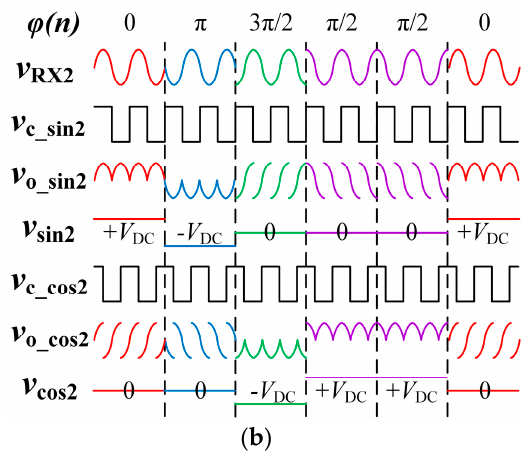
Figure 10. Amplitude measurement: ( a ) circuit; ( b ) waveforms.